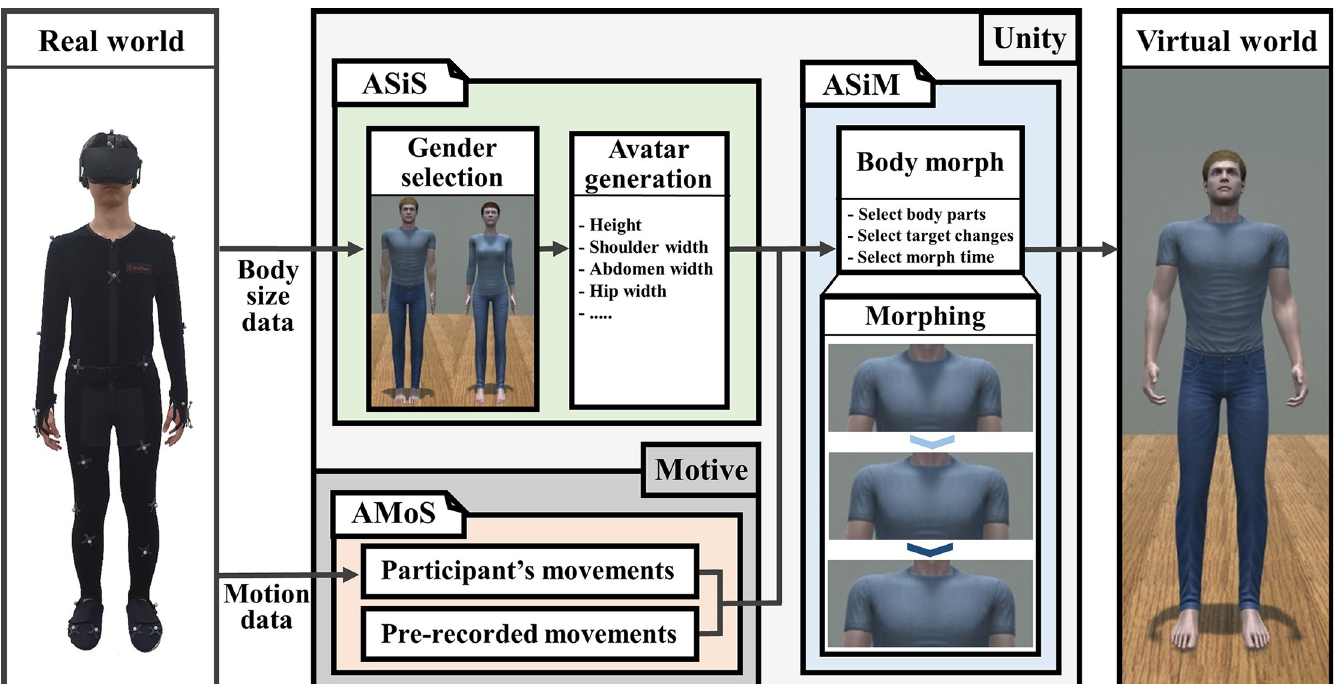
Fig 1. Methodology including avatar size synchronizer (ASiS), avatar size morpher (ASiM), and avatar motion synchronizer (AMoS). The ASiS is designed to make changes to the body size of the virtual avatar using input values from the participant’s actual body size and gender, the ASiM is designed to change the size of the virtual avatar from A to B during a designated amount of time, and the AMoS is designed to adjust the level of motion synchrony.